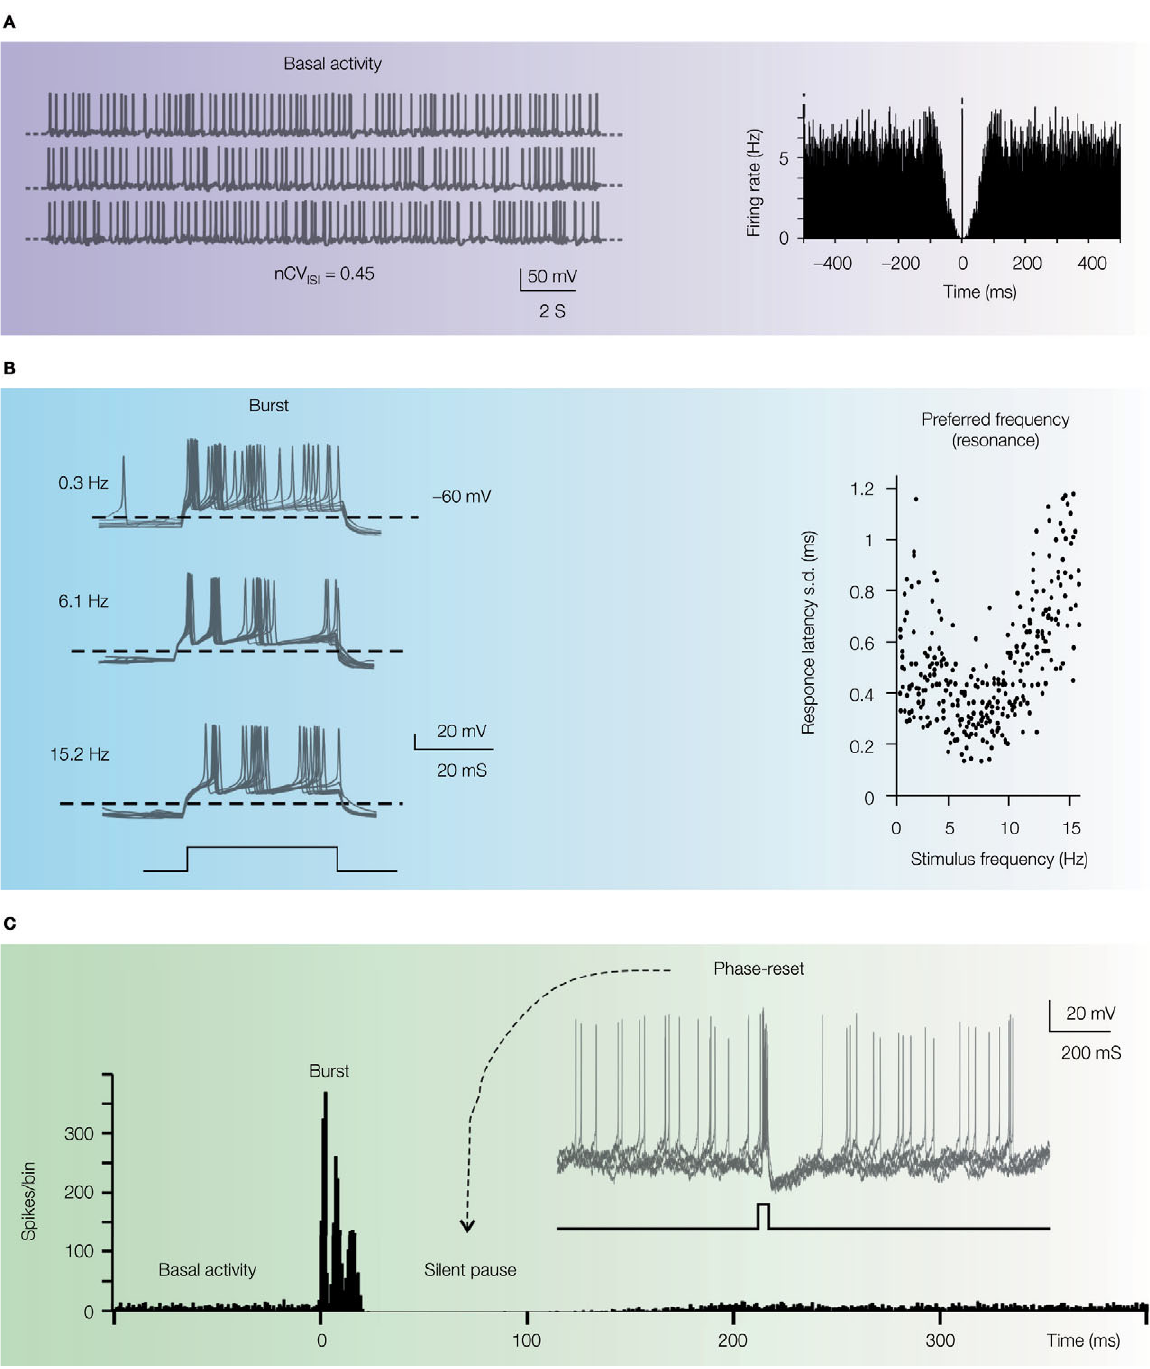
Figure 4 | Intrinsic electroresponsiveness II: matching in vivo responses. The panels report numerical simulations of Golgi cell responses added with balanced = 0.45 (Vos et al., 1999a) the regular synaptic noise to simulate in vivo conditions. (A) Pacemaking . Once perturbed with balanced synaptic noise to achieve nCV ISI pacemaking of the Golgi cell transforms into a discharge with random appearance, in which no periodic peaks can be revealed in the autocorrelation plot (right plot). (B) Preferred frequency . The Golgi cell injected with short depolarizing pulses (bottom trace) generates spike doublets-triplets very similar to those evoked by punc- tuate stimulation of the whisker pad. Repetition of the pulses at different frequencies reveals increased precision in fi rst spike latency at around 5 Hz, demonstrating a form of response resonance (right plot). (C) Phase reset . The rhythmic basal discharge of the Golgi cell is interrupted by a pulse like those shown in (B) . Thereafter, the cycle is phase-reset generating a silent pause similar to that observed in vivo . The main panel shows the PSTH of responses in subsequent trials (note that the spike triplet causes three peak in the PSTH at t = 0 followed by a period devoid of any spikes). The inset shows a collection of simulated voltage responses (gray traces). The basal beating is interrupted by spike triplets (caused by a short current pulse, black trace at the bottom) which phase-reset the response. Adapted from Solinas et al.